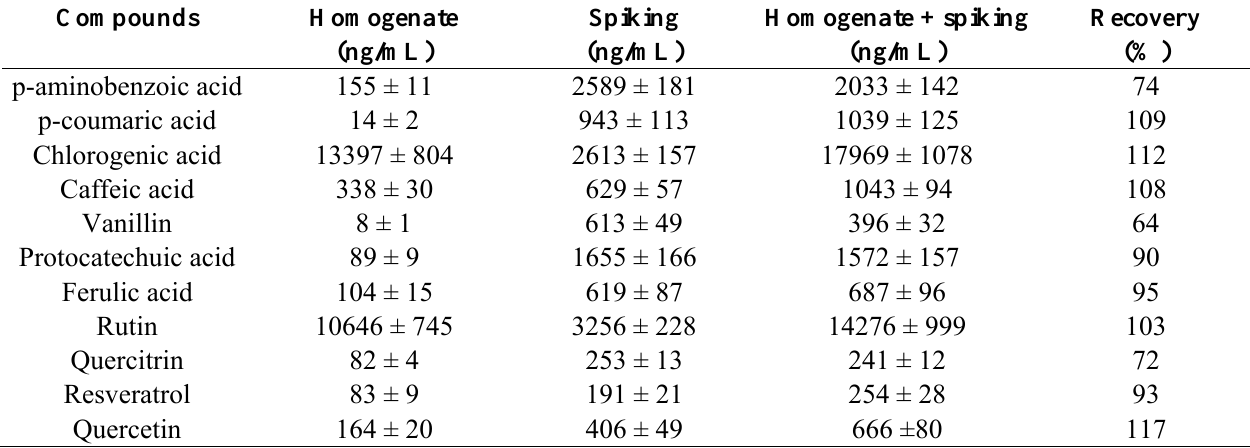
Table 10. Shaking 4